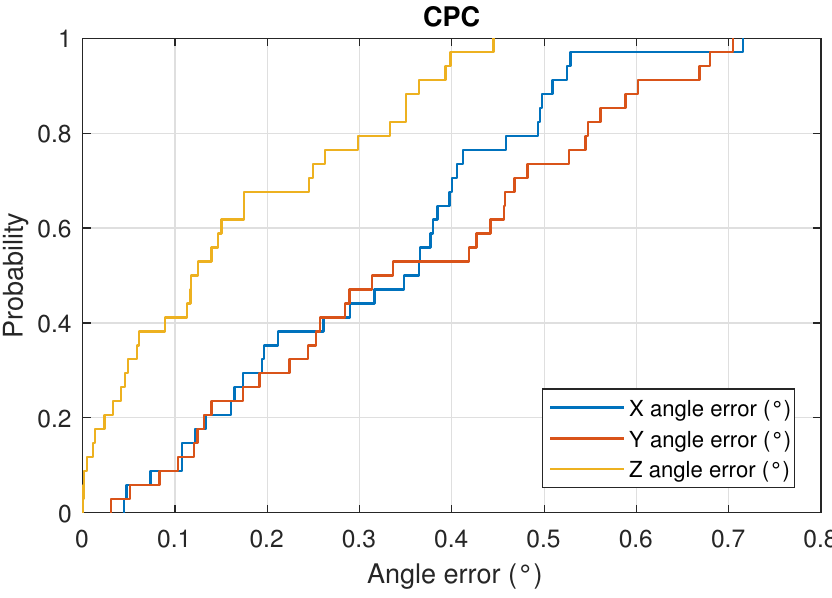
Figure 19. CDF of the angle error in the 3 axes using